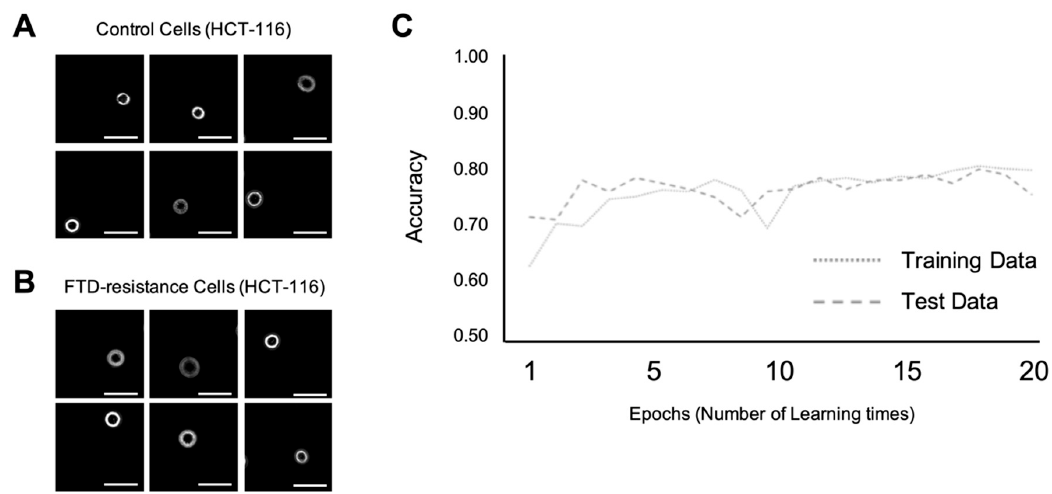
Figure 4. Machine learning at single-cell level for HCT-116 cell resistant and non-resistant to anticancer drugs. Scale bar; 50µm ( A ) Representative input images of the control HCT-116 cell. Scale bar; 50µm ( B ) Representative input images of the drug-resistant HCT-116 cell. ( C ) Accuracy variation per epoch.